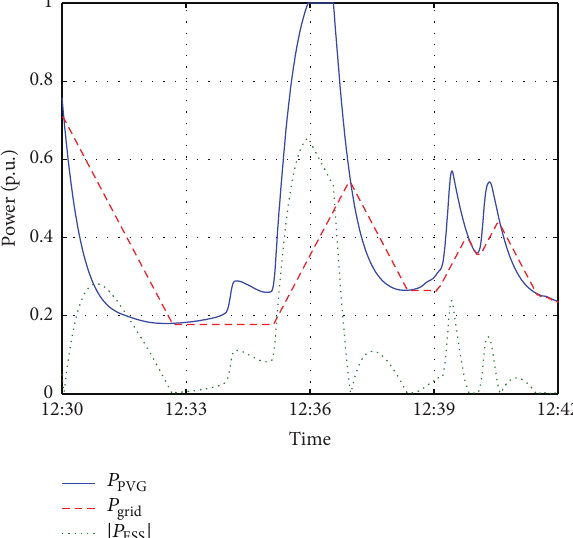
Figure 9: Output power of the 0.55 MWp PV generator, grid feed- in power, and the absolute power of ESS during the formation of the maximum ESS power requirement on 08.09.2012 while complying with RR limit of 1%/min.